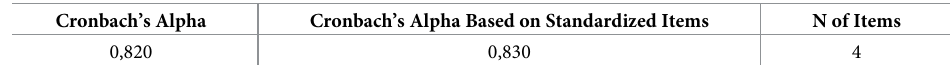
Table 15. Reliability statistics for subscale 3 (DLGs).